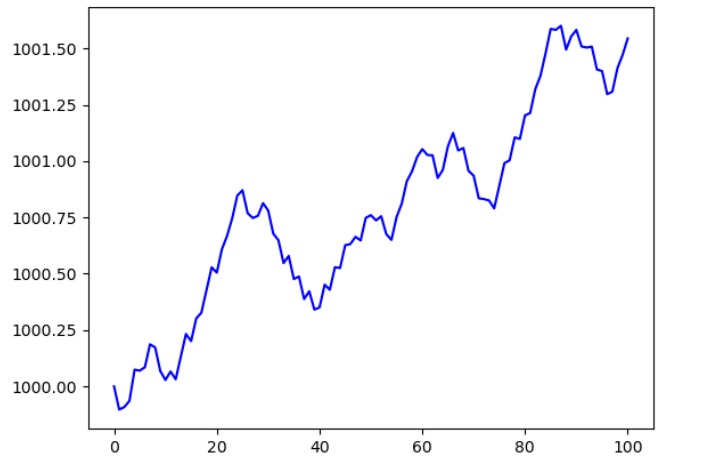
Figure A5. EURUSD Margin , 10 s.